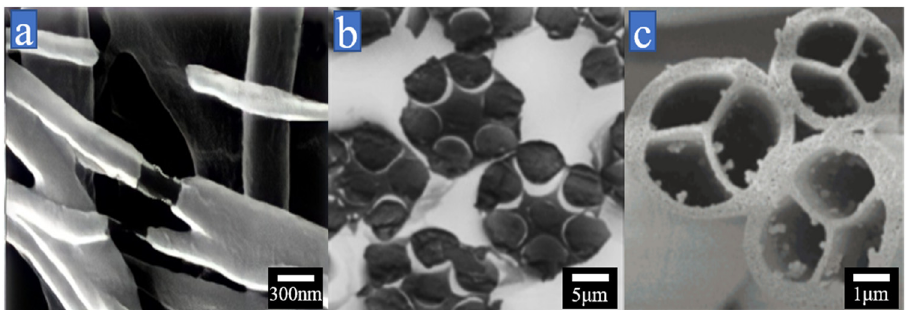
Figure 6: SEM images of ( a ) core/shell PVA/ZrO 2 composite nano fi bers, ( b ) INS web with several numbers of islands in the sea, and ( c ) hollow segment - pie bicomponent fi bers. ( a ) Adapted with permission ( 115 ) Copyright 2014, The Korean Fiber Society and Springer Business Media Dordrecht; ( b ) adapted with permission ( 116 ) Copyright 2011, Springer Science Business Media, LLC; ( c ) reproduced with permission (